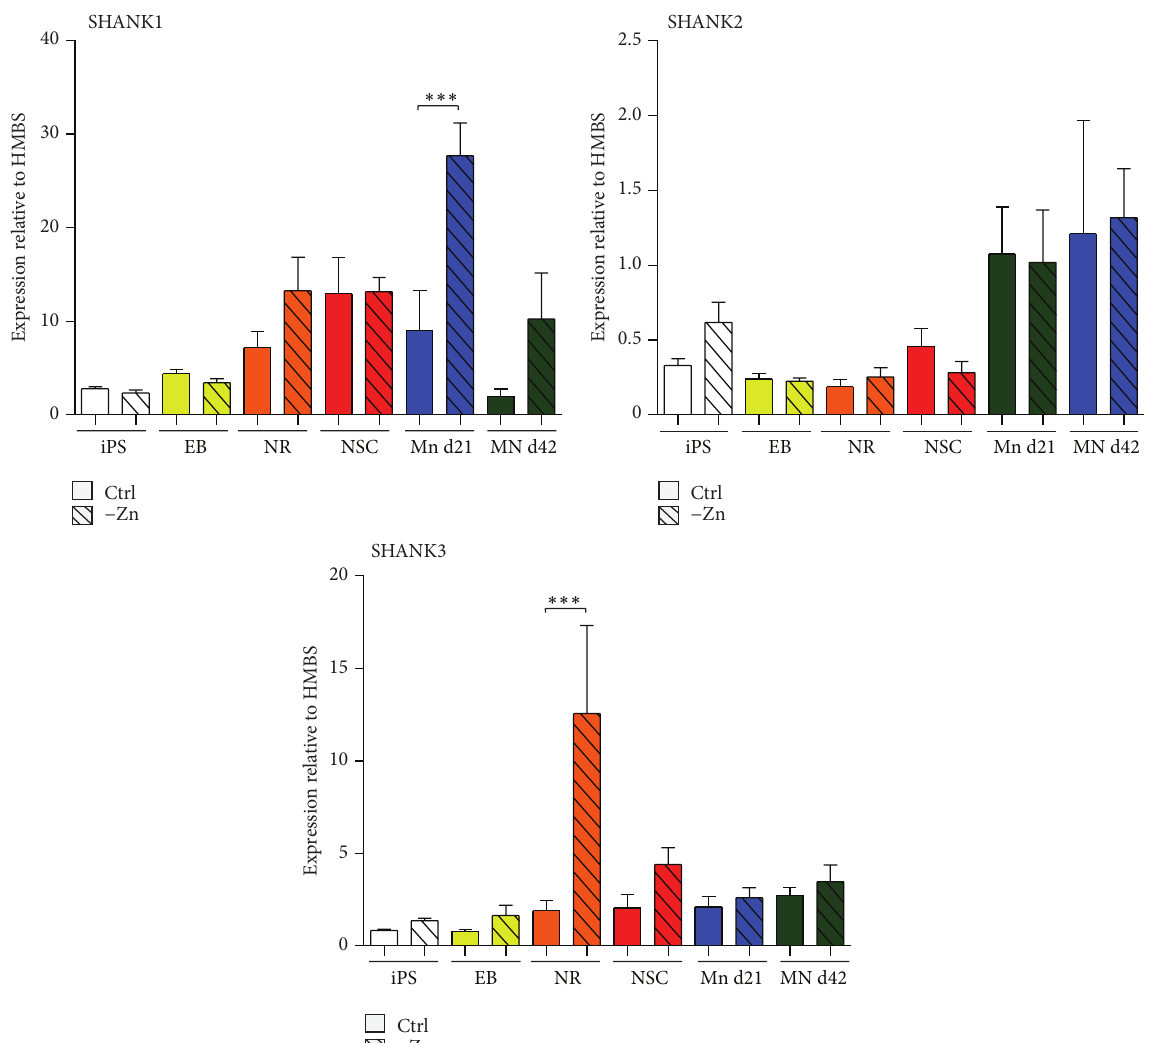
Figure 2: Zinc deficiency alters the expression of zinc homeostasis genes during stem cell differentiation into motor neurons. Quantitative evaluation of mRNA expression levels normalized to HMBS of selected zinc homeostasis and the zinc-dependent SHANK genes. Data shows the average normalized gene expression based on 𝑛 = 6 measurements. Neurofilament H (NEFH) expression was used to control successful differentiation. For statistical analysis, a 1-way ANOVA was used followed by Tukey’s multiple comparison test. Several zinc transporters show expression levels depending on the availability of zinc in the medium. Comparing cells grown in zinc depleted medium with cells grown in medium which was resupplemented with zinc in the amount used in control medium after zinc depletion, a significant difference in ZnT1 expression was found in d42 motor neurons (one-way ANOVA: 𝑝 < 0.0001 ; MN d42 Ctrl versus − Zn: 𝑝 < 0.05 ). No significant difference was detected regarding the expression of ZnT2, ZnT3, ZnT4, ZnT6, and MTF1 comparing controls and zinc deficient conditions. The expression of ZnT5 was significantly increased in motor neurons at d21 under zinc deficient conditions (one-way ANOVA: 𝑝 < 0.0001 ; MN d21 Ctrl versus − Zn: 𝑝 < 0.05 ). The expression of ZIP1 was significantly reduced in neuronal stem cells under zinc deficient conditions (one-way ANOVA: 𝑝 = 0.0012 ; NSC Ctrl versus − Zn: 𝑝 < 0.05 ). The expression of ZIP3 was not found to be altered, similar to the expression levels of MT2A. MT3 expression was significantly higher in neuronal stem cells under zinc deficient conditions (one-way ANOVA: 𝑝 < 0.0001